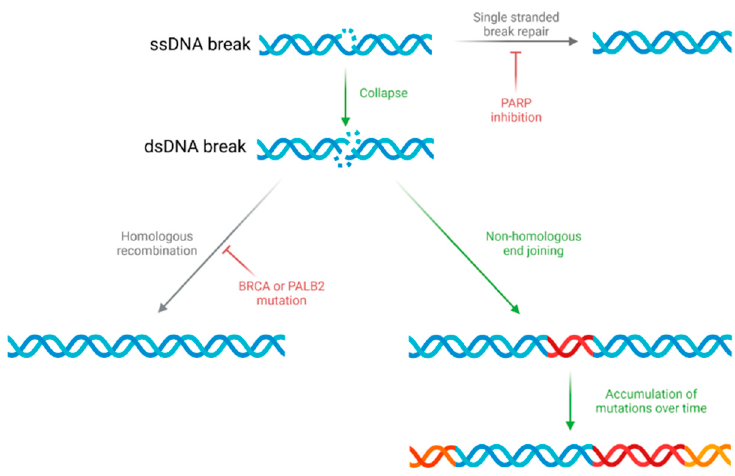
Figure 2. The mechanism of PARP inhibitor-induced cell death. PARP inhibitors prevent cells from carrying out single-stranded DNA (ssDNA) break repair, resulting in the collapse of ssDNA breaks into double-stranded DNA (dsDNA) breaks. In cells with BRCA or PALB2 mutations, homologous recombination cannot occur and hence dsDNA breaks must be repaired through the more error-prone mechanism of non-homologous end-joining. This results in mutations (red), which accumulate over time to induce synthetic lethality.